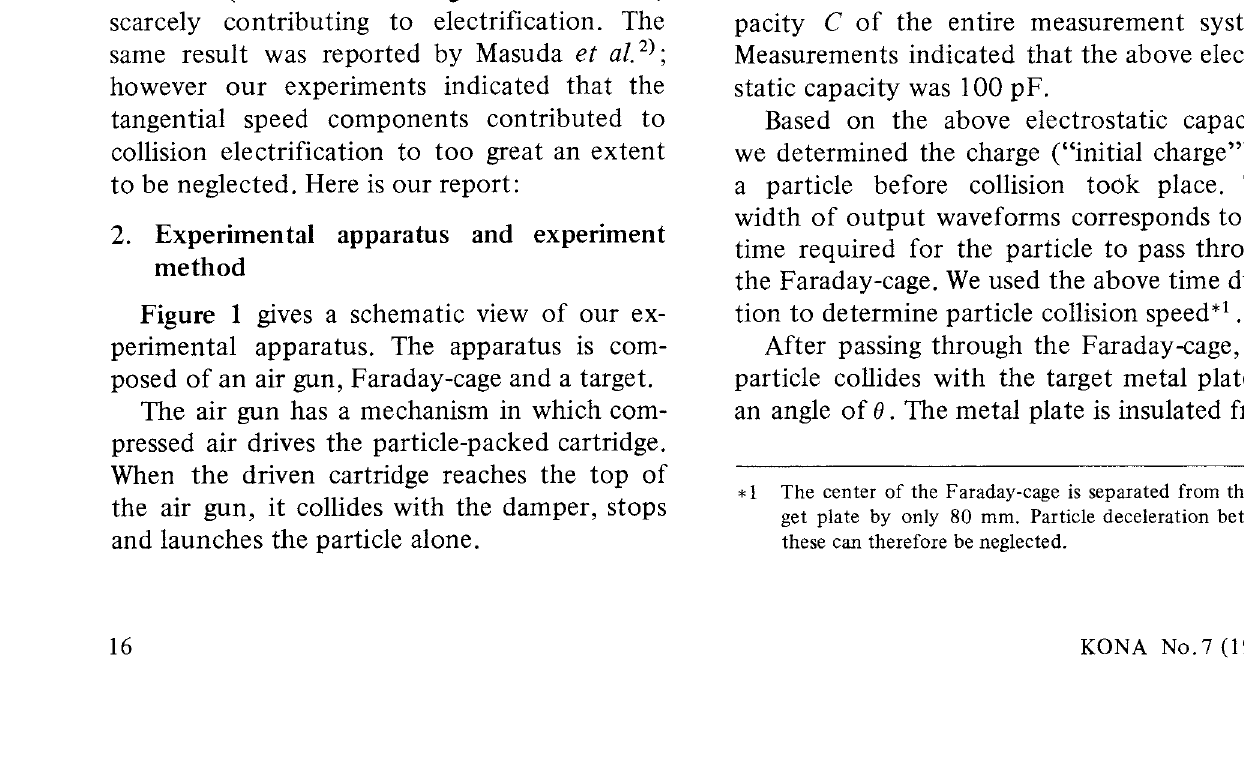
Fig. 1 Schematic view of the